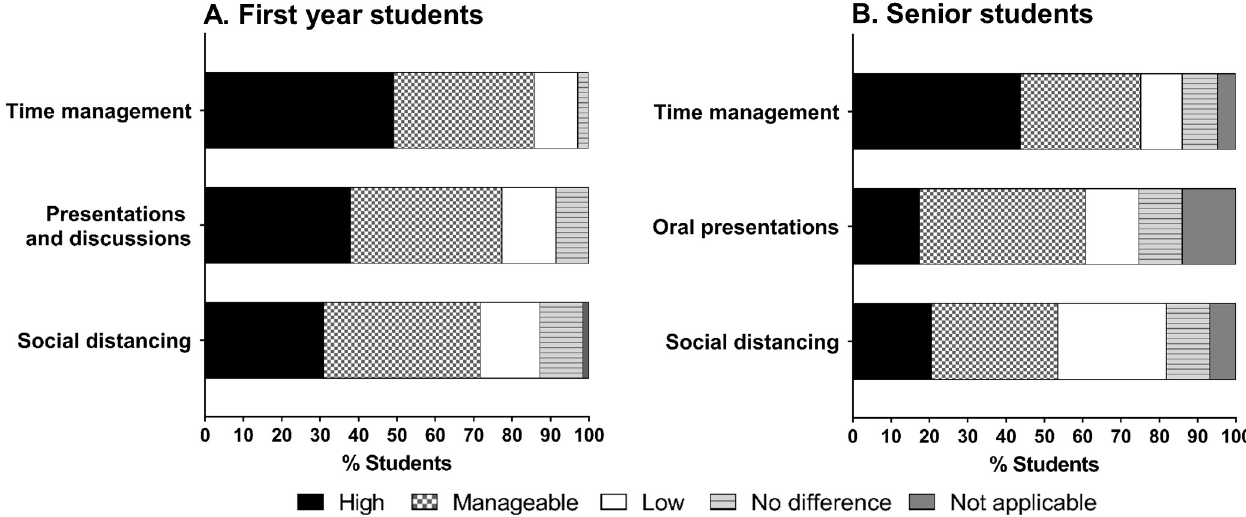
Fig 2. Level of stress associated with other aspects of remote learning. Students were asked to indicate their level of stress with various aspects of remote learning. Responses from (A) first year students (n = 71) and (B) senior students (n = 194) are shown.